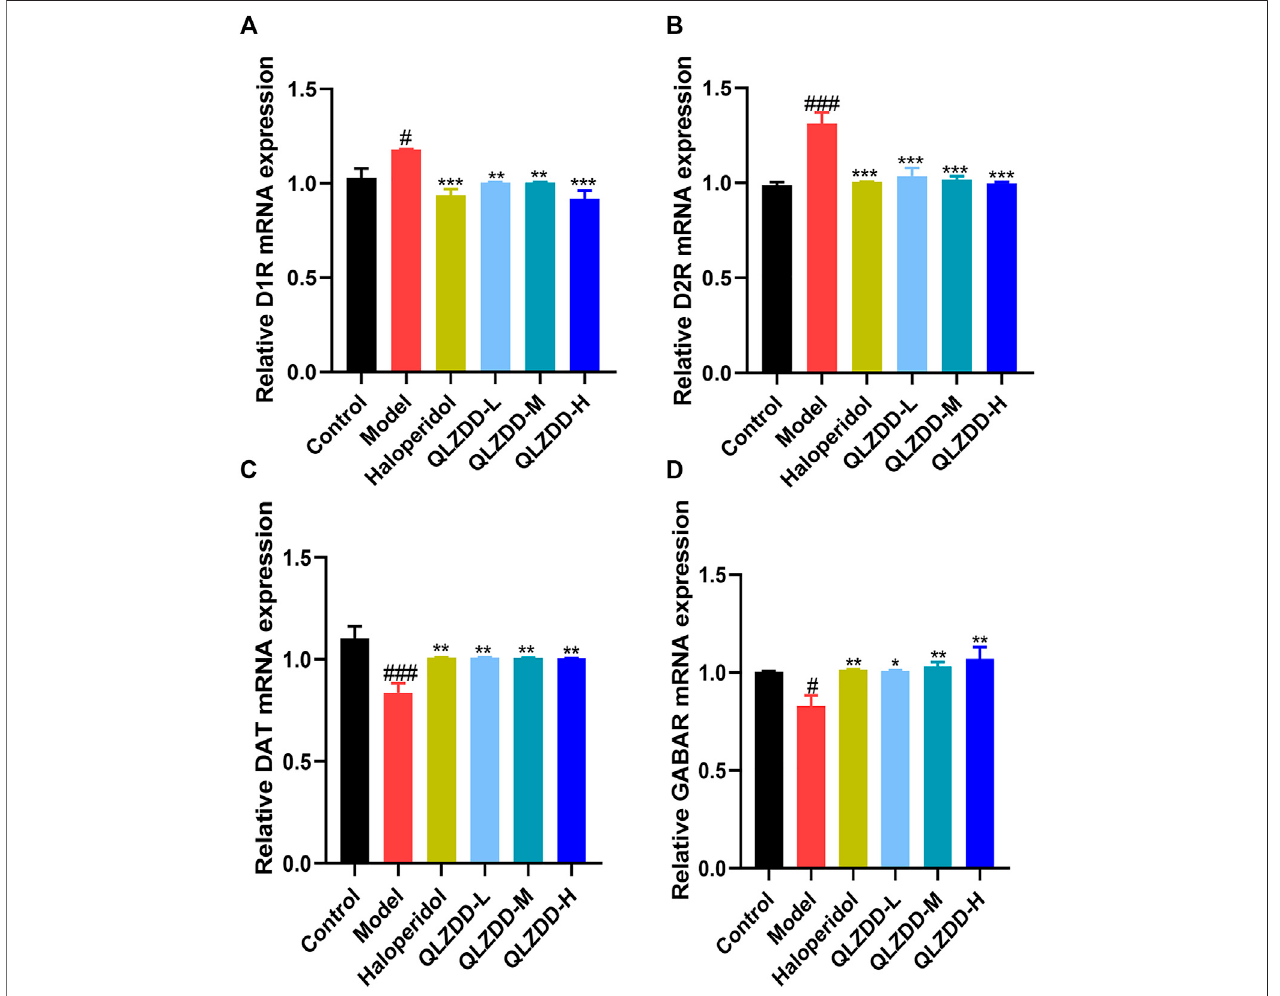
FIGURE4| TheeffectofQLZDDonthemRNAexpressionofD1R,D2R,DAT,andGABAR. (A) TheleveloftheD1RmRNAexpressioninserum, (B) thelevelofthe D2R mRNA expression in serum, (C) the level of the DAT mRNA expression in serum, and (D) the level of the GABAR mRNA expression in serum. All data were expressed as mean ± SD ( n = 3 mice). One-way ANOVA was used to compare the data of the QLZDD groups with the data of the control group. ### p < 0.001 in comparison with the model group. * p < 0.05, *** p < 0.01, and *** p < 0.001.